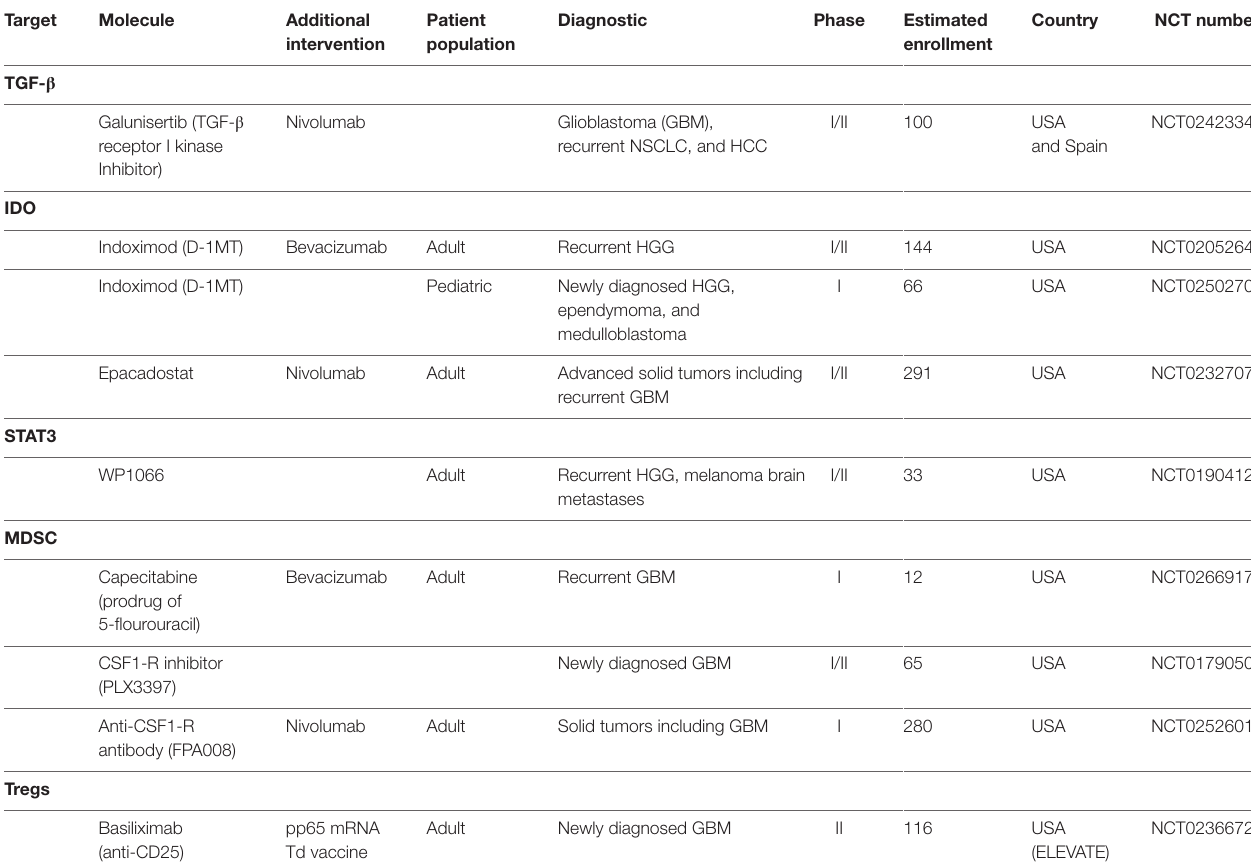
TABLe 3 | Currently ongoing trials targeting the tumor microenvironment. Target